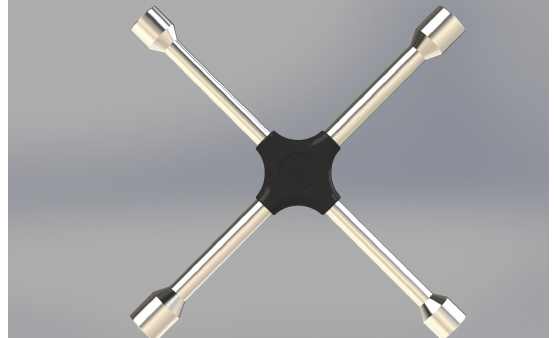
Figure 1. The tool used in a human–robot cooperation scenario for screwing a bolt. Since the human and the robot together screw the cross tool, the human arm might be obstacles to the robot during the bolt screwing process.